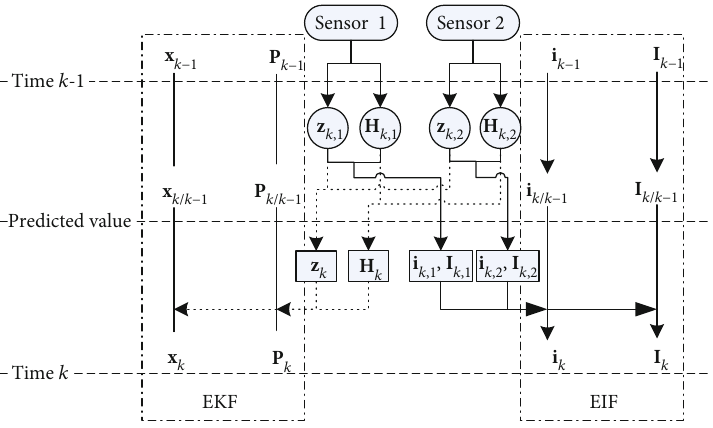
Figure 4: Comparison of EKF and EIF.